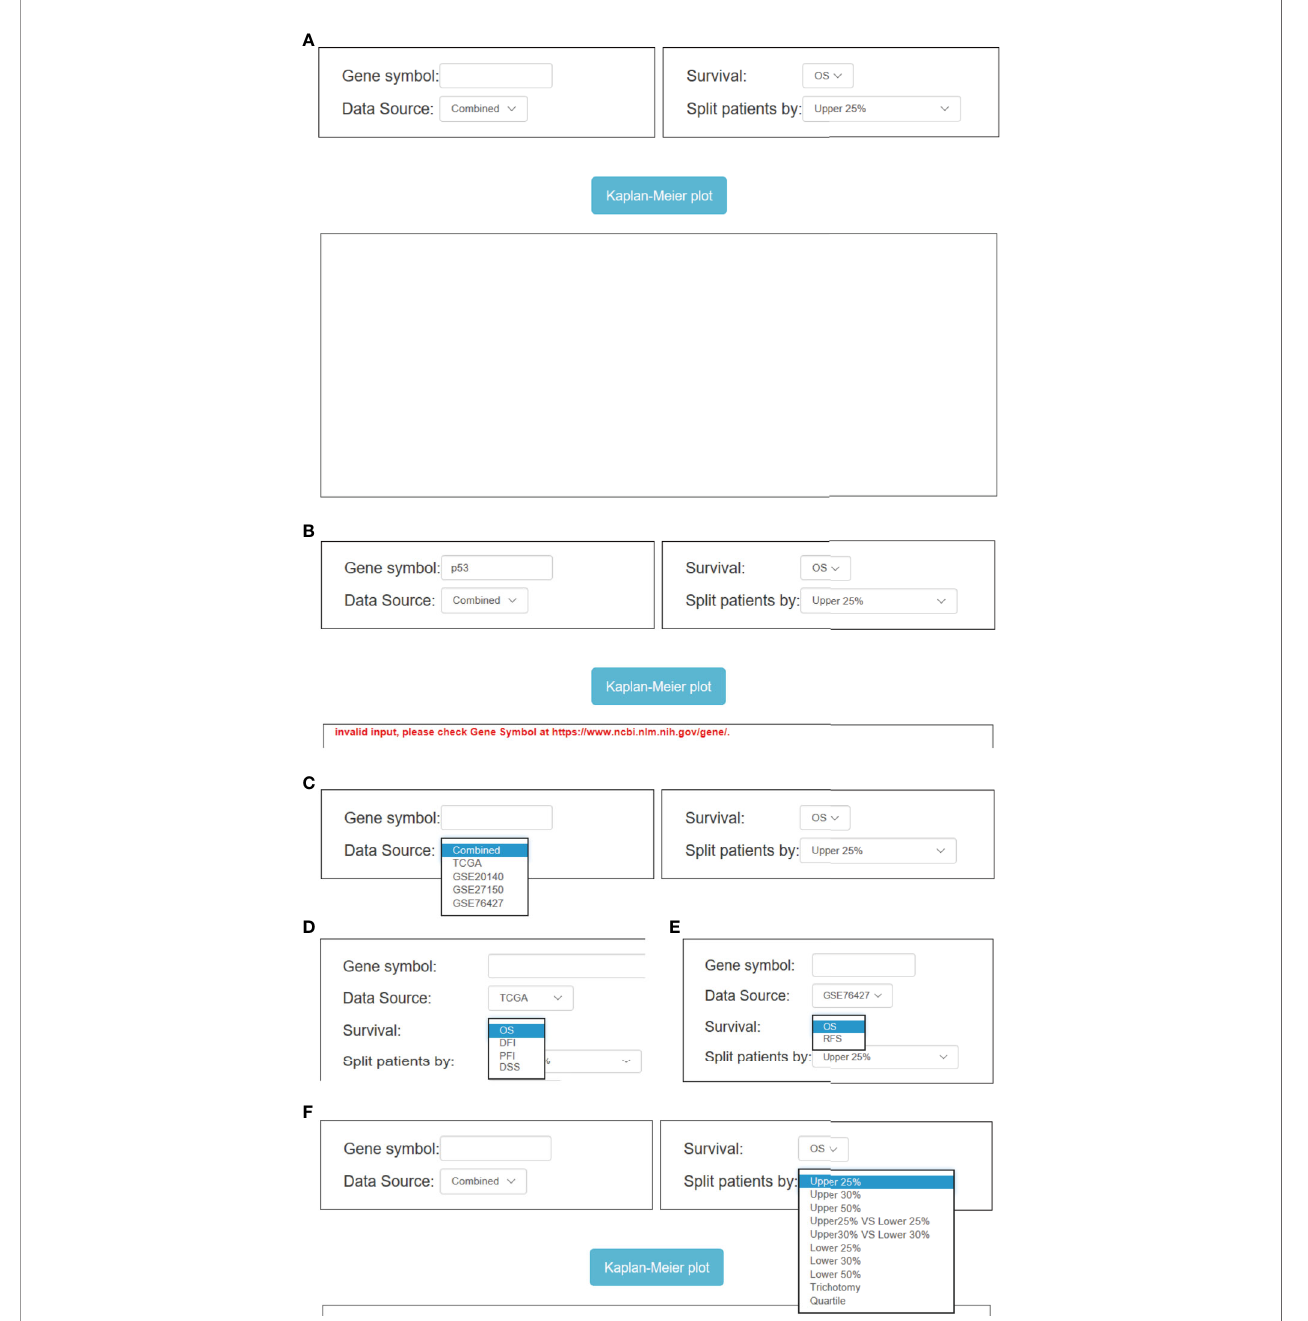
FIGURE 3 | Overview of OSlihc. (A) Screenshot of OSlihc main interface. (B – F) Input and output interface of